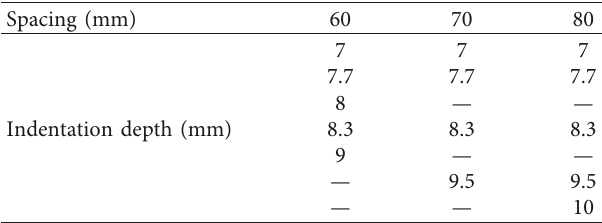
Table 2: Spacing and indentation depth in laboratory